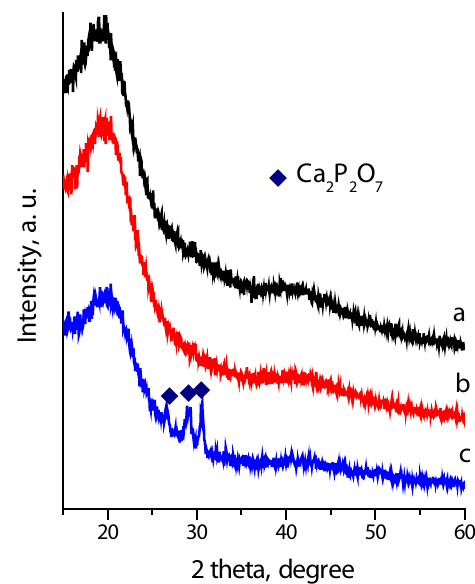
Figure 1. XRD for pure PU (a), PU/10BG (b) and PU/20BG